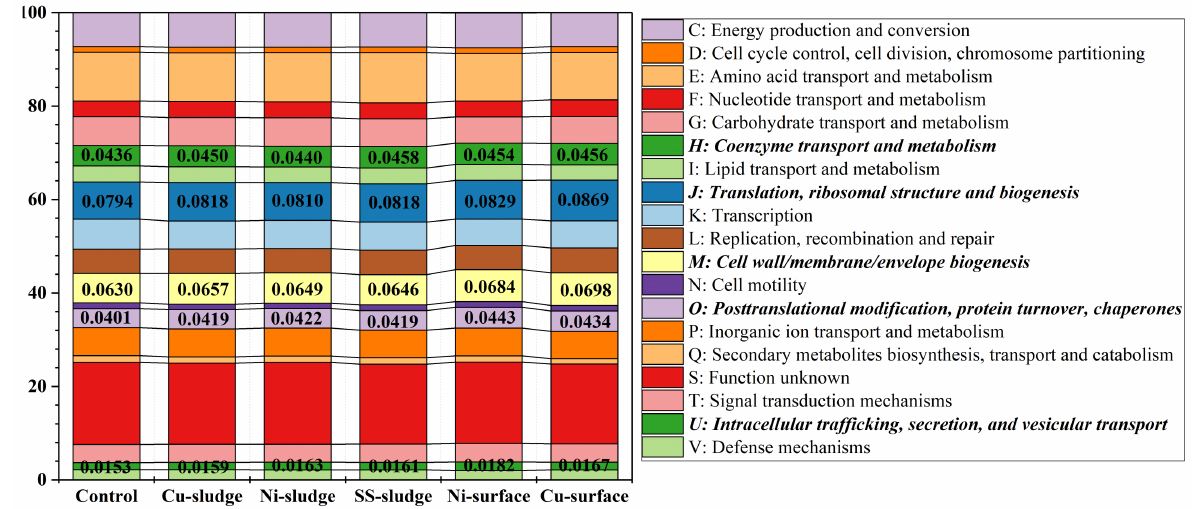
Figure 8. COG function classification based on the 16S rRNA gene sequencing of sludge and metal surface